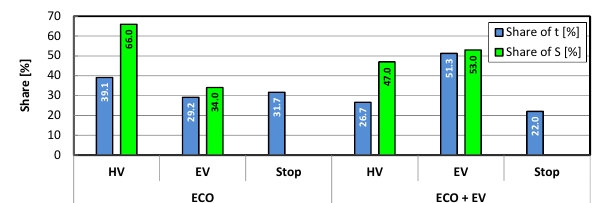
Fig. 6. The share of hybrid and electric mode in urban traffic conditions in relation to the road and time of the vehicle test drive After summing up individual vehicle energy flow